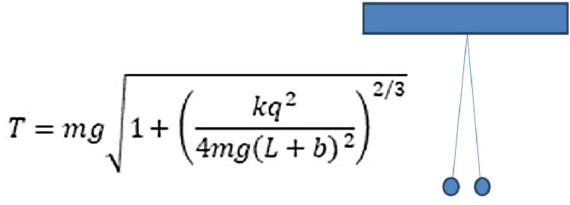
FIG. 3. Proposed tension in symmetric suspended charged balls